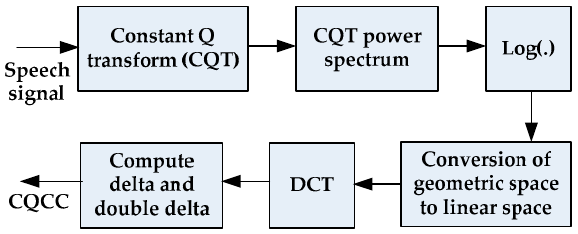
Figure 2. Extraction of constant Q cepstral coefficient (CQCC) features as proposed in ref. [10]. 40- dimensional delta + double delta coefficients are used as